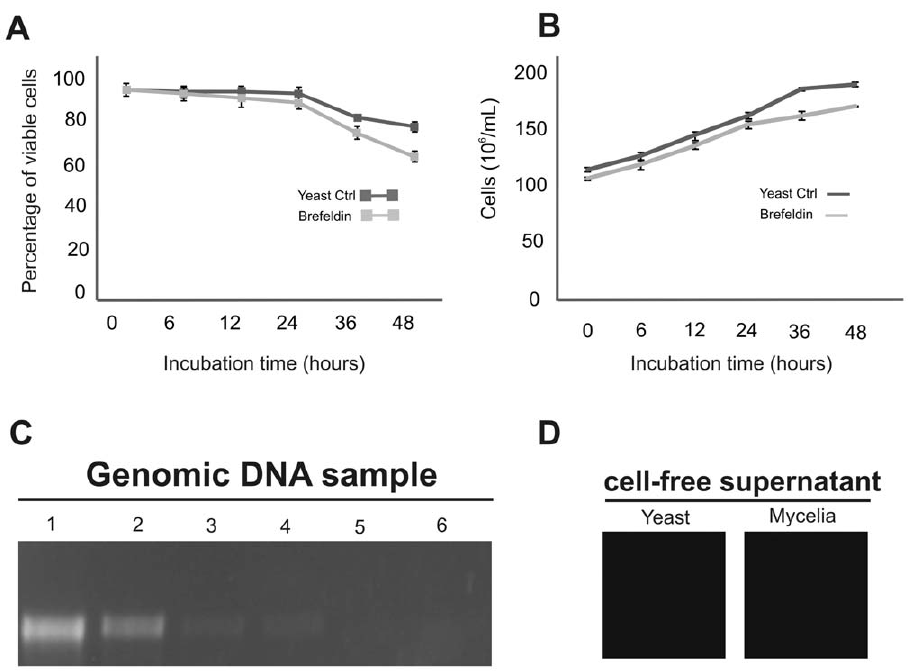
Figure 1. Validation of the extracellular protein extraction method. A- The viability of Paracoccidioides yeast cells incubated in Fava Netto’s liquid medium (dark gray square) and the incubation of yeast cells in Fava Netto’s liquid medium containing 6 m g/mL Brefeldin A (light gray square). Viability was assessed using trypan blue staining. The error bars represent the standard deviation of three biological replicates. B- The growth of Paracoccidioides yeast cells in liquid medium in either the absence (dark line) or presence of 6 m g/mL Brefeldin A (light gray line). Culture growth was evaluated by quantifying the number of yeast cells per mL. The error bars represent the standard deviation of three biological replicates. C- PCR sensitivity for the formamidase gene was assessed using Paracoccidiodes Pb01 genomic DNA (at five dilutions) as a template (50 ng to 1 pg). Lanes: 1 presence of Paracoccidiodes DNA via PCR using oligonucleotides specific for the formamidase gene.